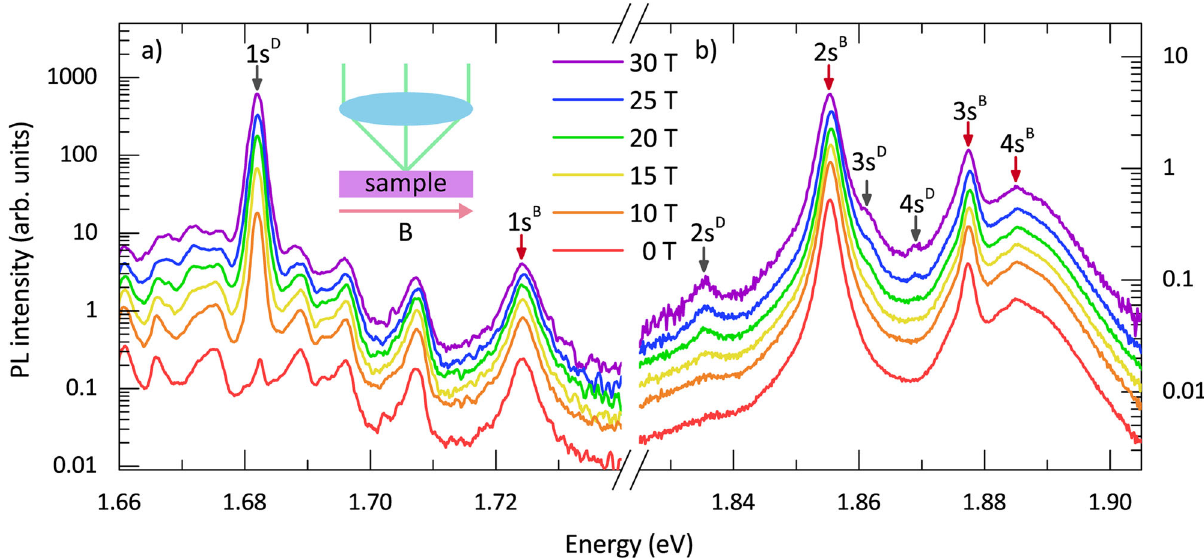
Fig. 2 Magnetic fi eld-dependence of emissions from bright and dark-exciton Rydberg states. Low-temperature photoluminescence (PL) spectra in arbitrary (arb.) units measured at selected in-plane magnetic fi elds in the energy region of both a ground and b excited states. Spectra were shifted for clarity and normalized to the 1s B feature in the lower energy region and to the 2s B feature in the higher-energy region. Note that the intensity scales differ for these two regions. The inset schematically shows the backscattering geometry used in the experiment, where the excitation and the collected light beams are quasi-perpendicular to the sample